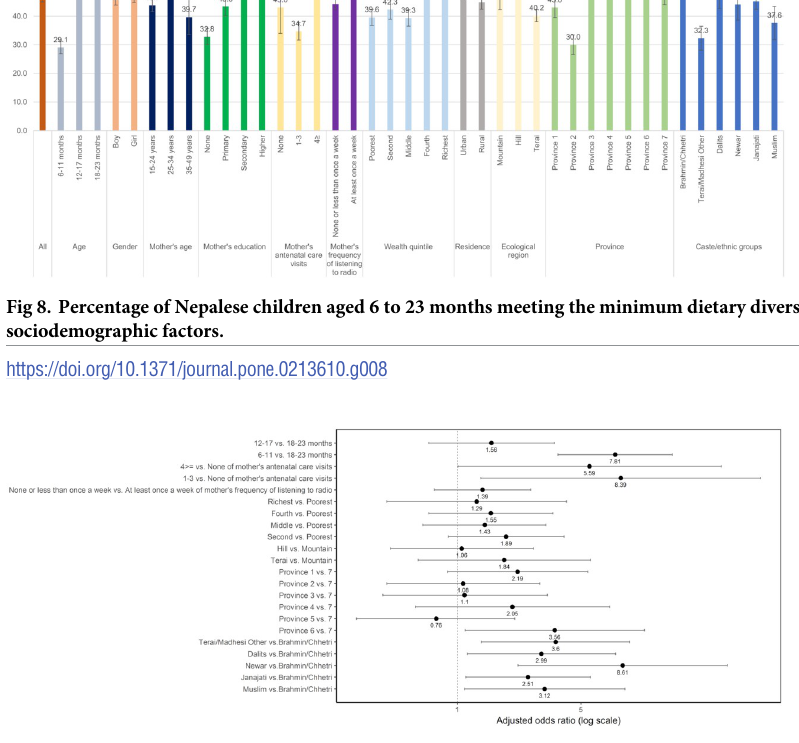
PLOS ONE | https://doi.org/10.1371/journal.pone.0213610 March 11,